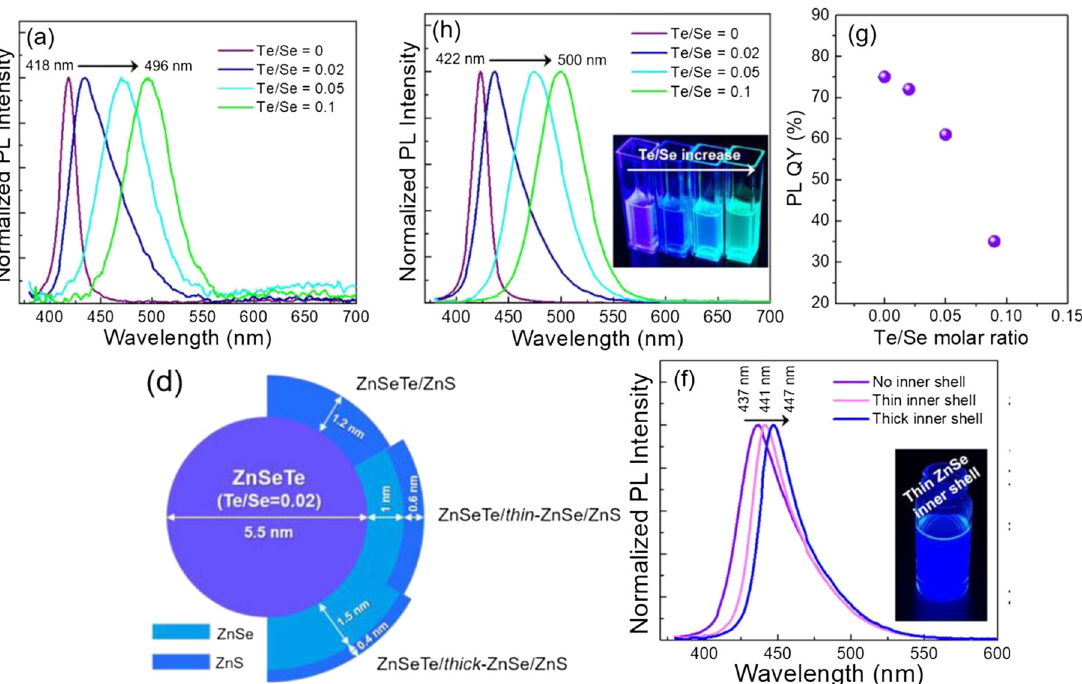
Figure 6: (a) Normalized PL spectra of ZnSeTe cores synthesized with different Te/Se molar ratios of 0 – 0.1; (h) Normalized PL spectra and fluorescent images (inset) and (g) change of PLQY of ZnSeTe/ZnS core/shell QDs as a function of Te/Se molar ratio; (d) Schematic of single- shelled ZnSeTe/ZnS, double-shelled ZnSeTe/thin-ZnSe/ZnS and ZnSeTe/thick-ZnSe/ZnS QDs heterostructures with information on shell thickness; (f) normalized PL spectra of QDs with no, thin, and thick ZnSe inner shell. The inset of (f) is a fl uorescent image of a representative QD sample of blue-emitting ZnSeTe/thin-ZnSe/ZnS